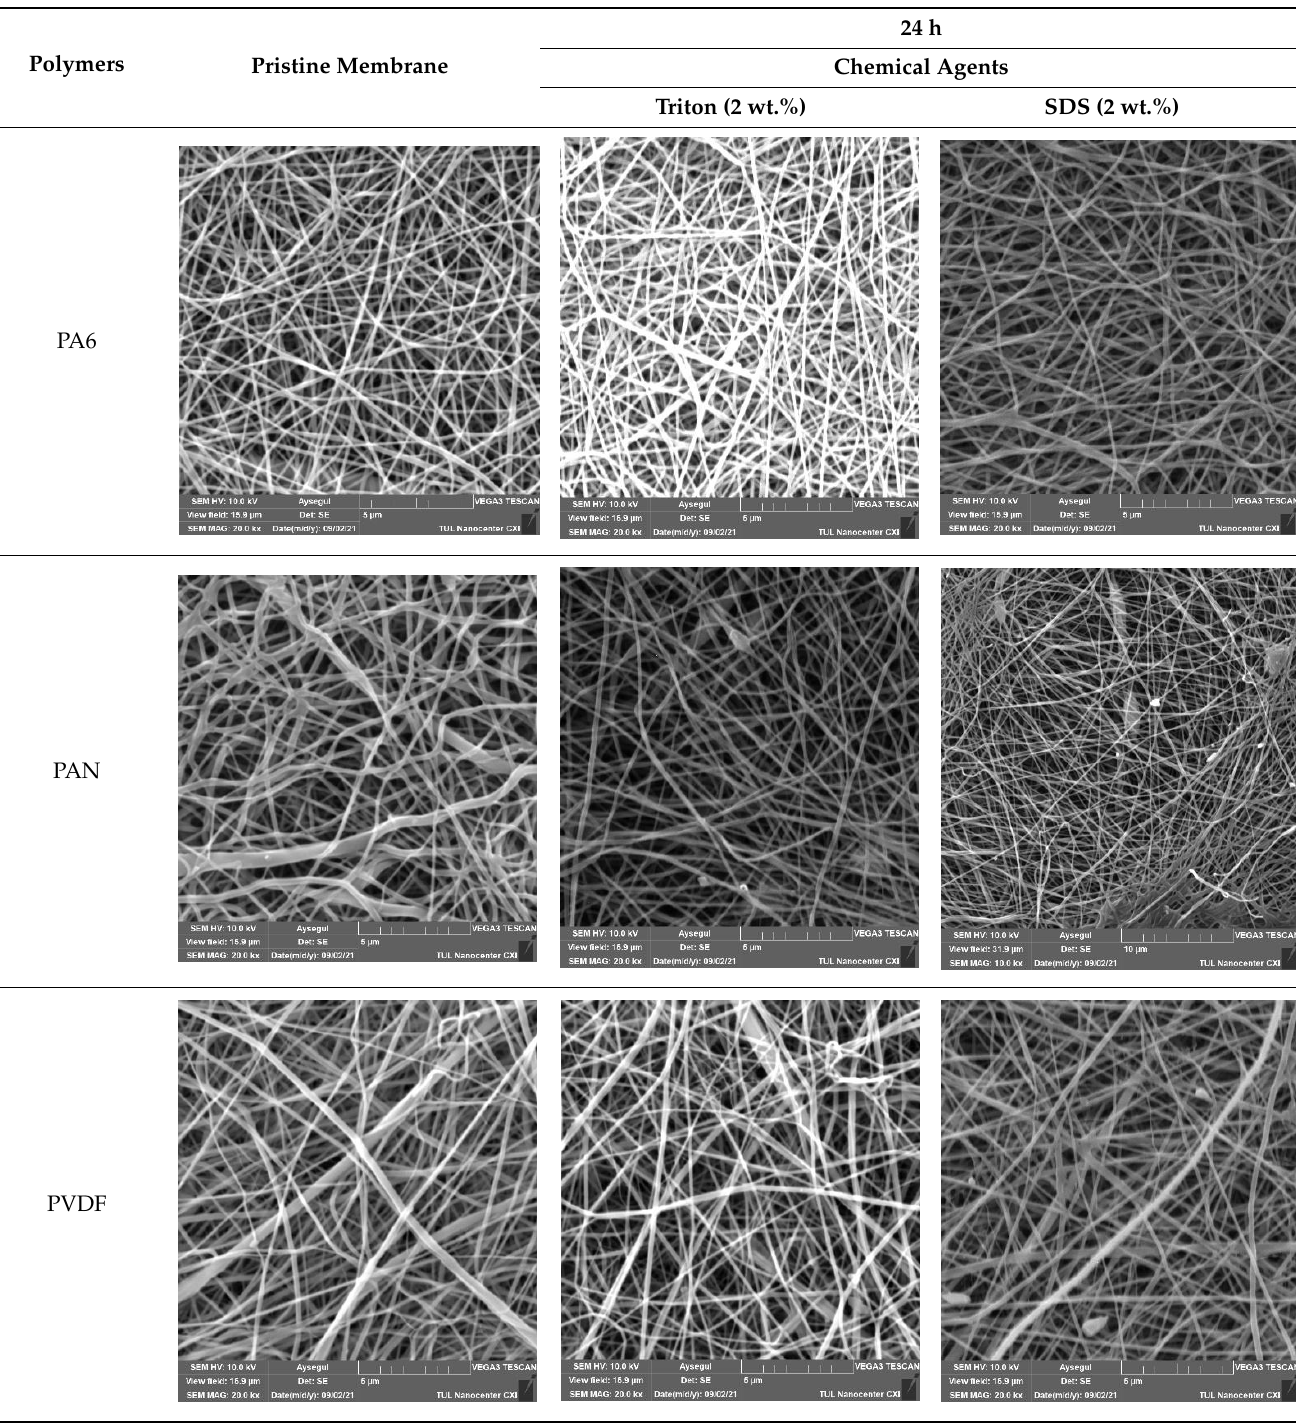
Table 7. SEM images of membranes after the application of chemical cleaning agents (2% Triton-2% SDS).